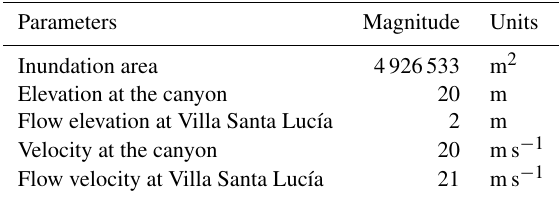
Table 3. Parameters for the calibration. Parameters Magnitude Units Inundation area 4926533 m 2 Elevation at the canyon 20 m Flow elevation at Villa Santa Lucía 2 m Velocity at the canyon 20 ms − 1 Flow velocity at Villa Santa Lucía 21 ms −